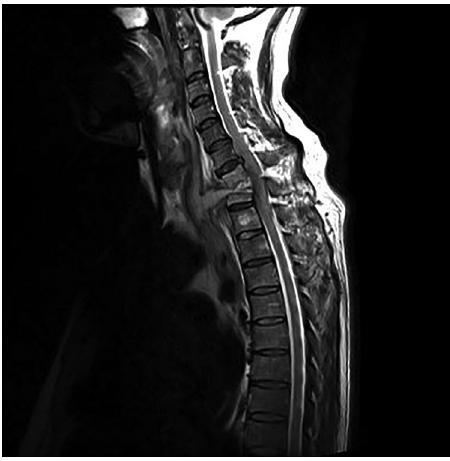
Figure 3. MR result of the thoracic vertebra before the operation.